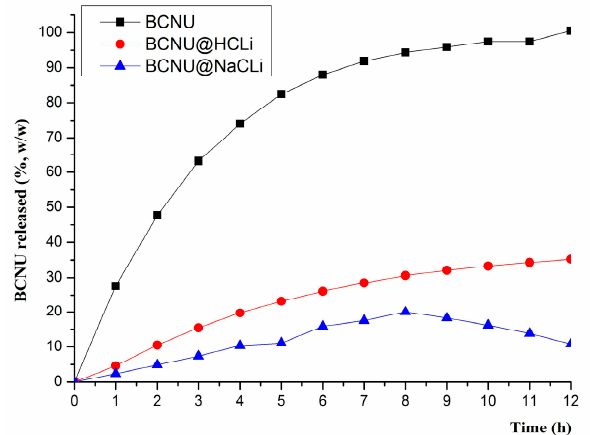
Figure 3. In vitro dissolution release of BCNU from modified delivery clinoptilolite-based systems.